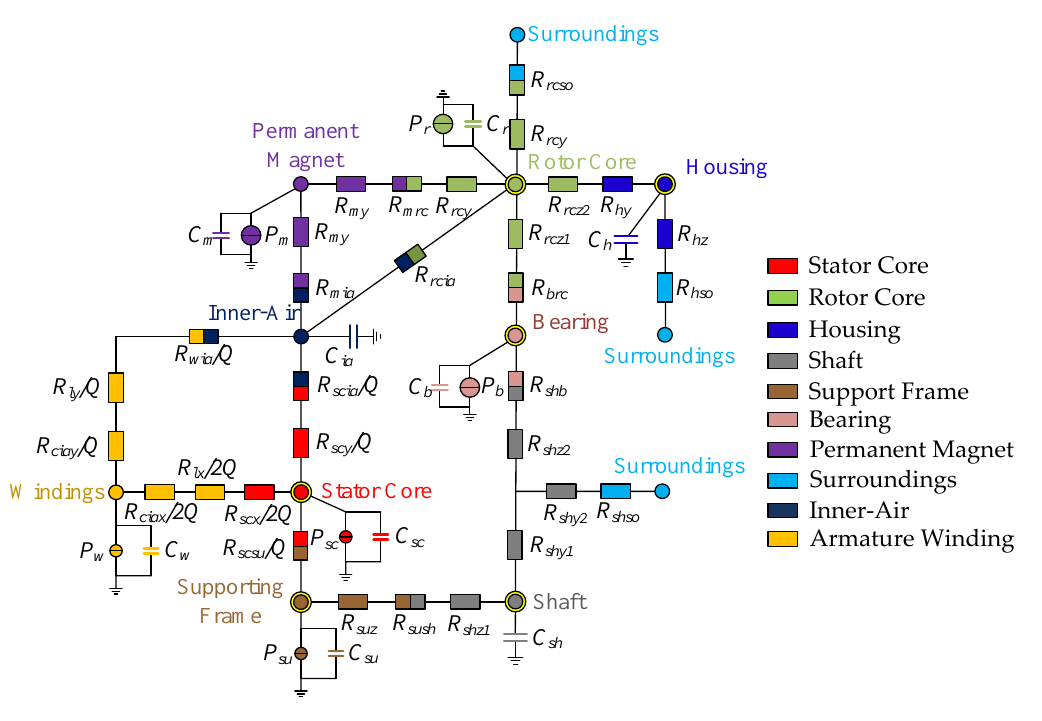
Figure 16. Entire thermal model of the YASA machine.